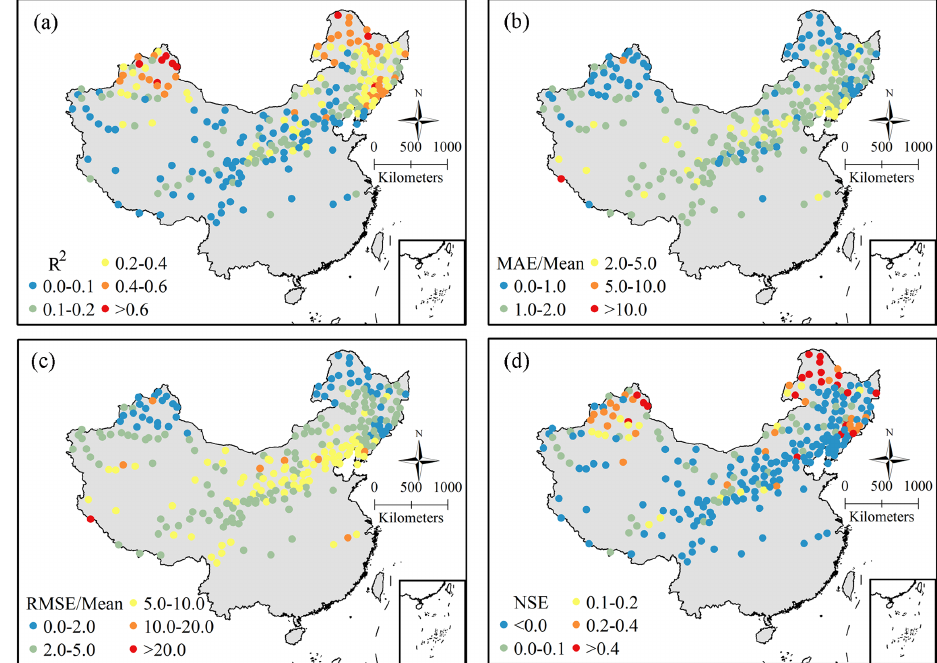
Figure 4. Statistical criteria of the calculated snow depth against observed snow depth at 264 meteorological stations in China. Panel (a) shows the R 2 (coefficient of determination). Panel (b) shows MAE / Mean, where MAE is the mean absolute error, and Mean is the monthly mean snow depth. Panel (c) shows RMSE / Mean, where RMSE is the root mean square error. Panel (d) shows the NSE (Nash–Sutcliffe efficiency).